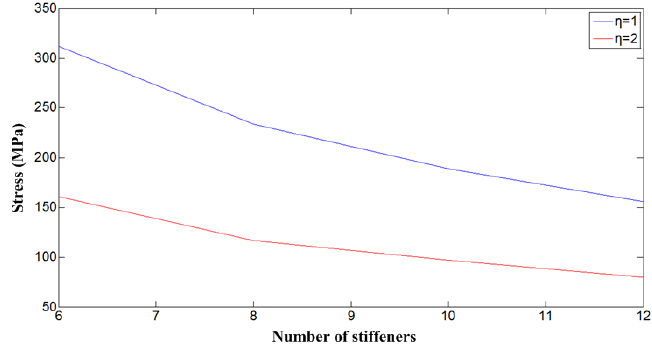
Figure 16. Influence of design parameters on the structural stress of ring.